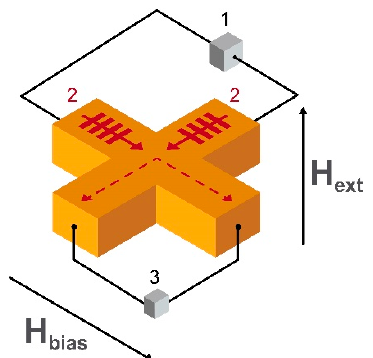
Figure 13. Schematic image of the sensing element of the spin wave-based magnetic field sensor consisting of a spin waves generator (1) exciting spin waves in two antennas (2) detected by the spin wave detector (3), where H ext and H bias are the applied out-of-plane and bias in-plane external magnetic fields, respectively.